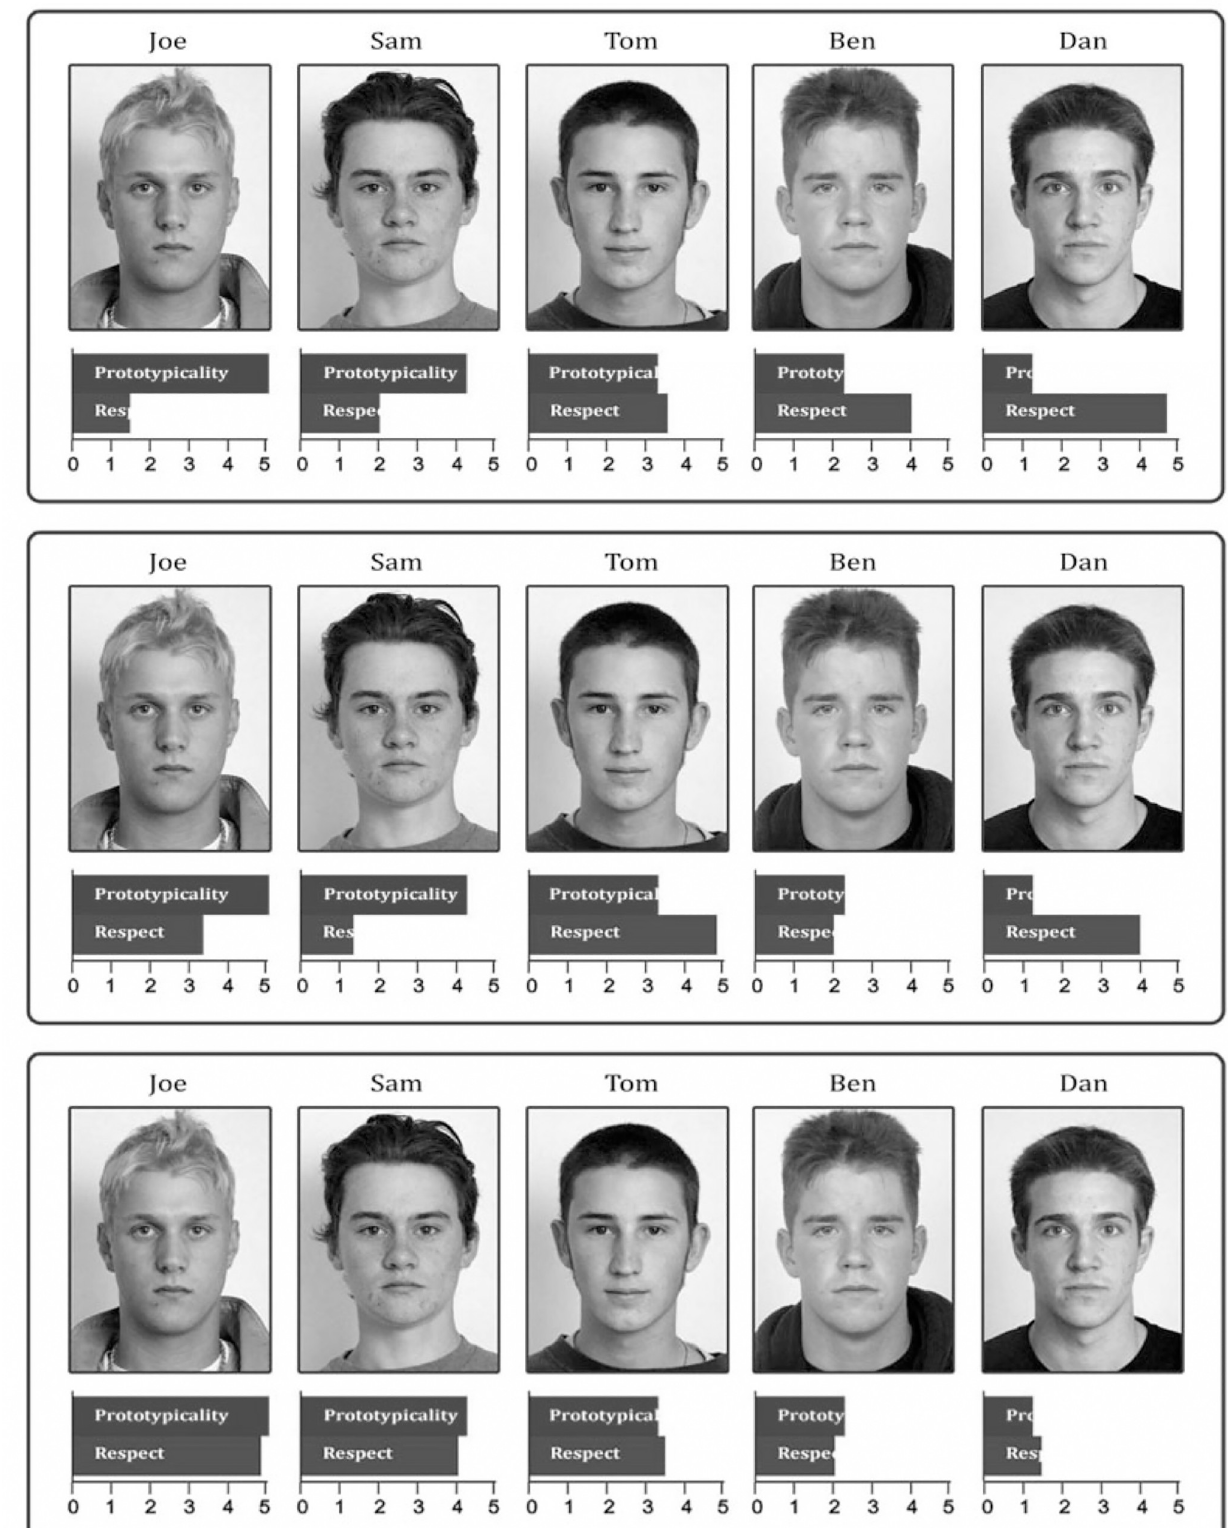
Fig 5. Conditions reflecting negative (top), neutral (middle), and positive (bottom) associations between prototypicality and respect. https://doi.org/10.1371/journal.pone.0243821.g005 PLOS ONE | https://doi.org/10.1371/journal.pone.0243821 December22,